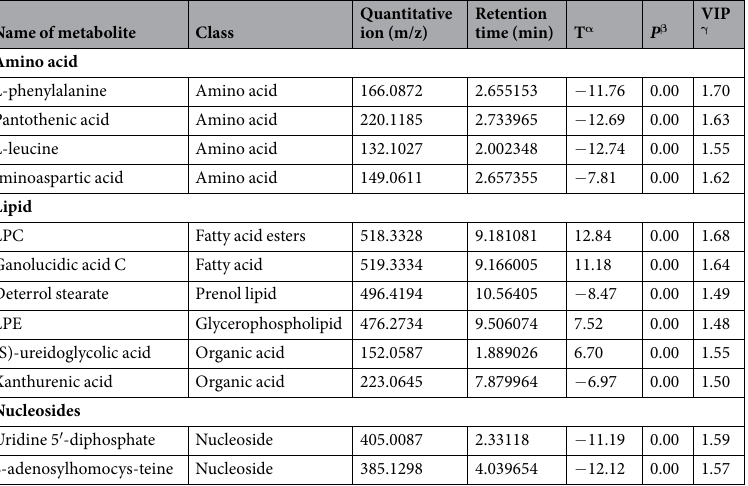
Table 13. Metabolites showing statistically significant differences between HA and LA. α Relative concentrations compared with LA: T > 0 indicates upregulated; T < 0 indicates downregulated. β P value determined using Student’s t test. γ Correlation coefficient and VIP values were obtained from orthogonal projection to the latent structures discriminant analysis.